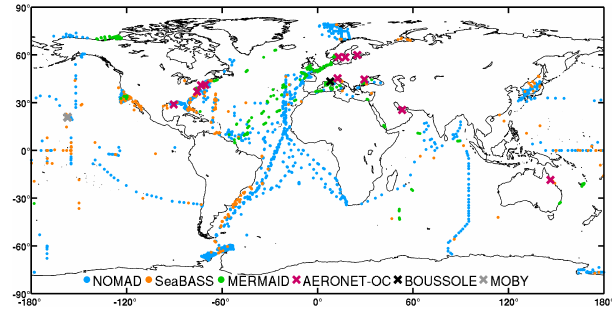
Figure 5. Global distribution of remote-sensing reflectance per dataset in the final table. The data sources are identified with dif- ferent colours. Points show locations where at least one observa- tion is available. Crosses show sites from where time series data of remote-sensing reflectance are available.